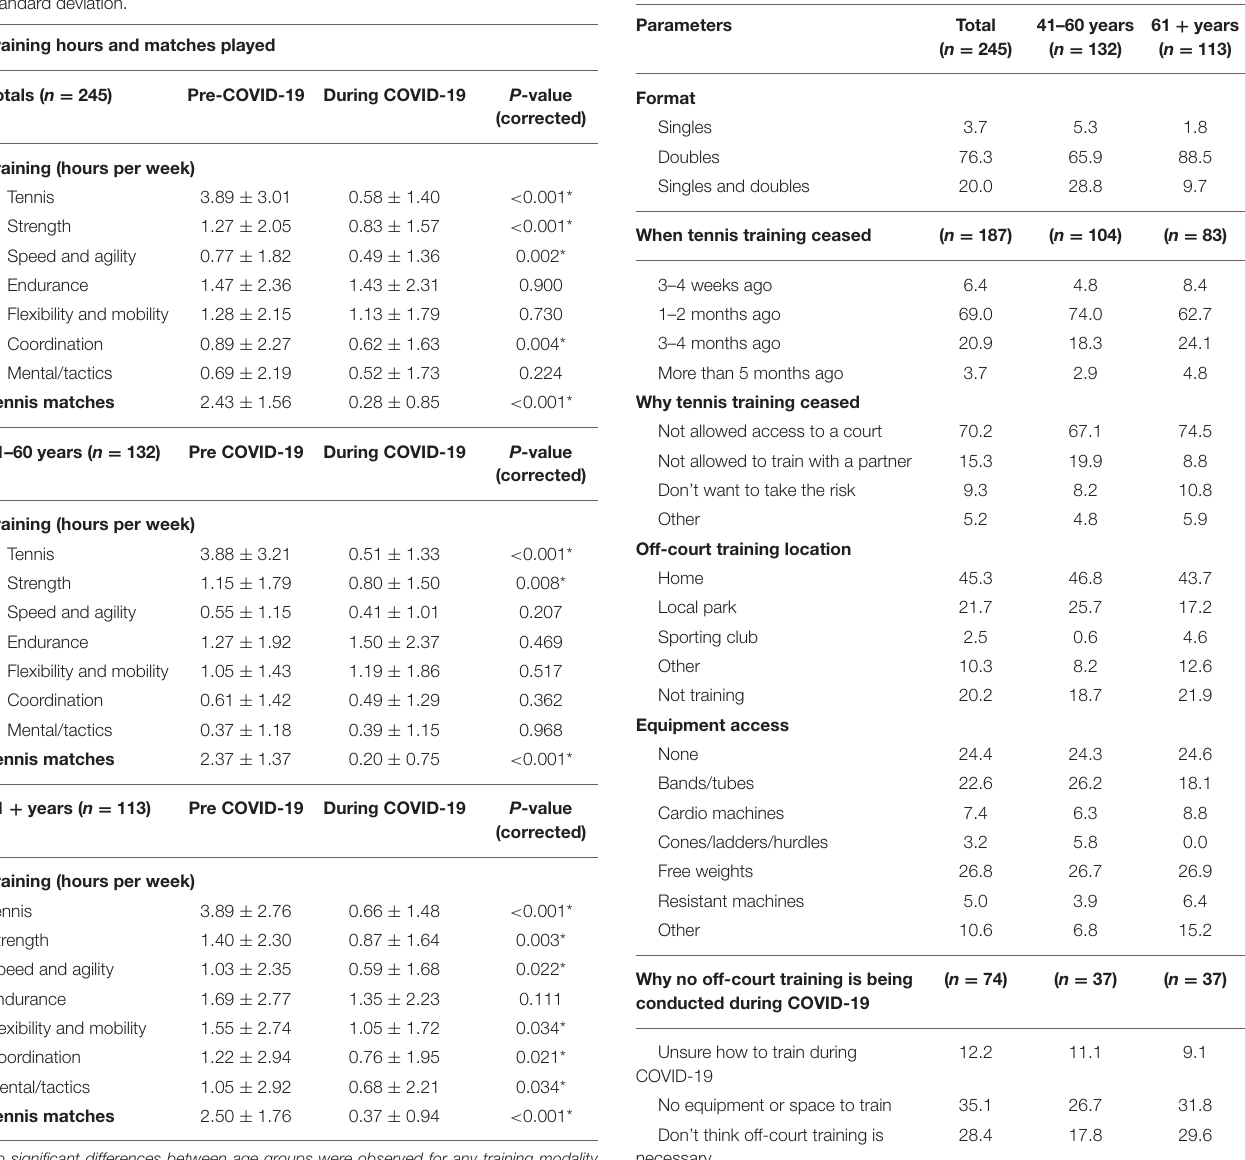
TABLE 2 | Training hours per week for various modalities and tennis matches played per week, before (pre-) and during COVID-19 presented as mean ± standard deviation.